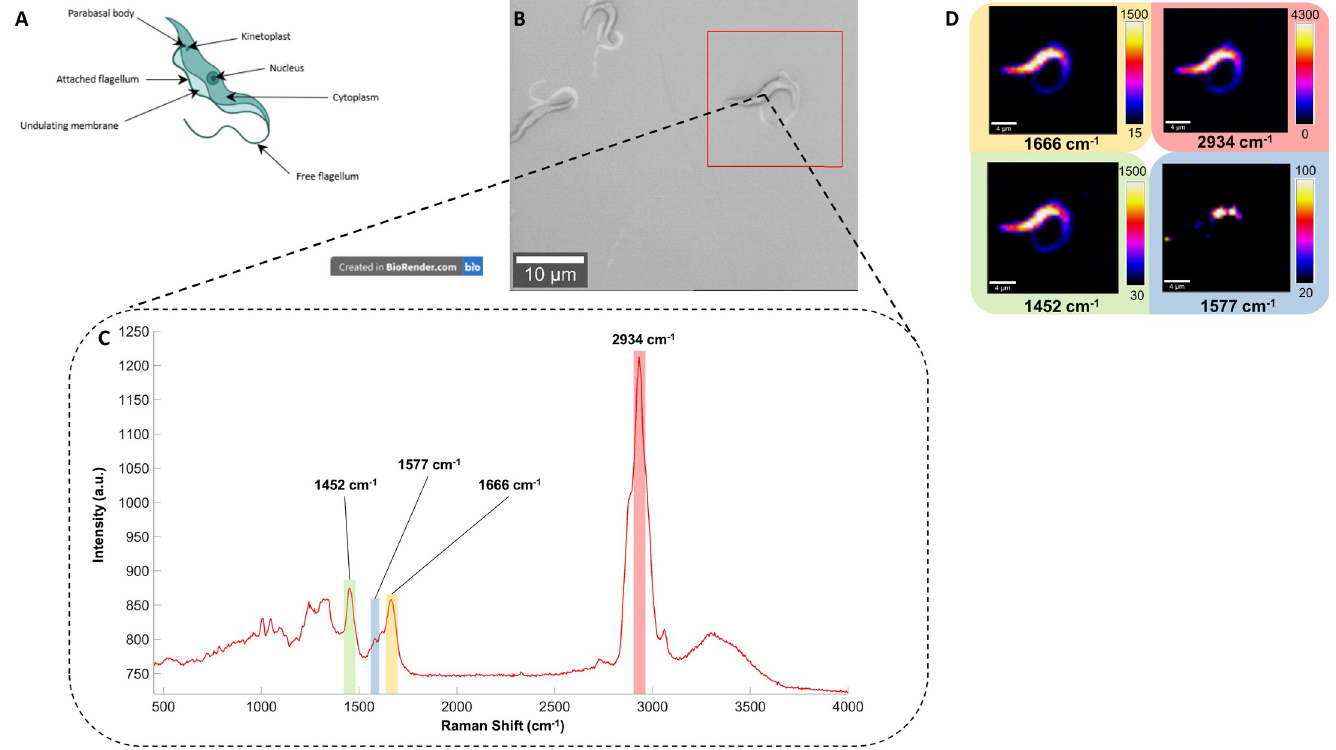
Fig 1. Raman spectrum of Trypanosoma brucei brucei strain STIB247 and some examples of its associated false colour image obtained with Raman measurements. Data obtained with a 532 nm laser, 6 s acquisition time and 100x lens. (A) A schematic of a bloodstream trypanosome (Created in BioRender.com), (B) white light image of T. b. brucei mapped where the red square correspond to 25 x 25 μ m mapped at 0.5 μ m step size, (C) representative Raman spectrum of the parasite, taken from a single point on the parasite, and (D) false coloured image associated of the Raman peaks 1452, 1577, 1666 and 2934 cm -1 with their respective intensity bar, which assign a colour gradient from the lowest (black) to the highest (white) intensity.